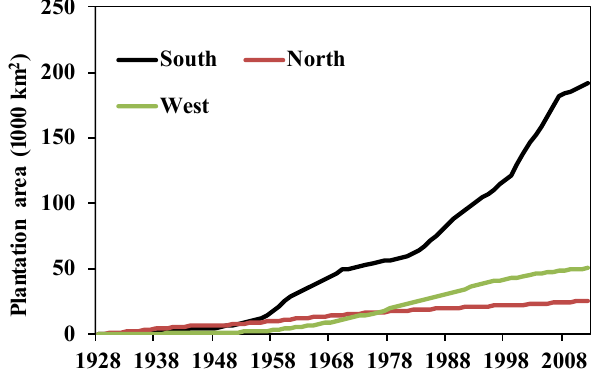
Figure 8. Total plantation forest area (1000km 2 ) for different re- gions in the CONUS during